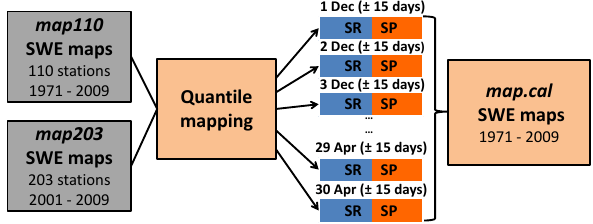
Fig. 7. Calibration procedure. SR refers to snow-rich and SP to snow-poor days. The distinction between snow-rich and snow-poor days is based on the median of map110 during the overlapping pe- riod.